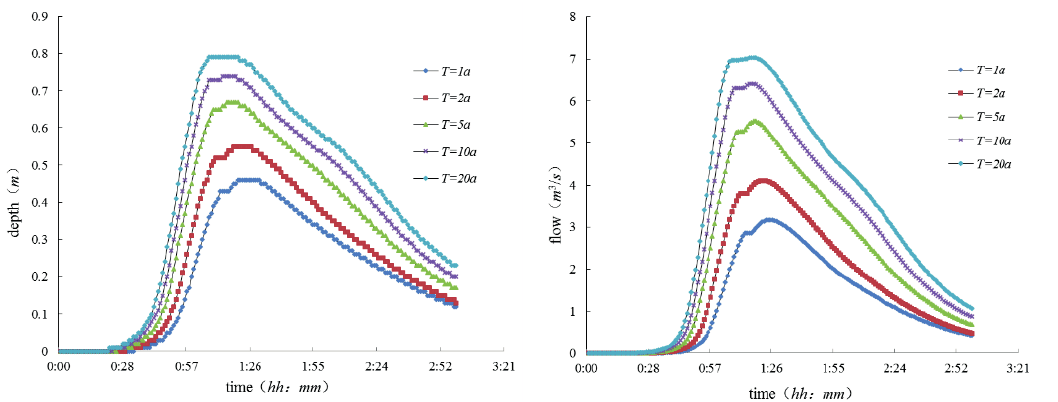
Fig. 5 Simulated discharge and water depth at the